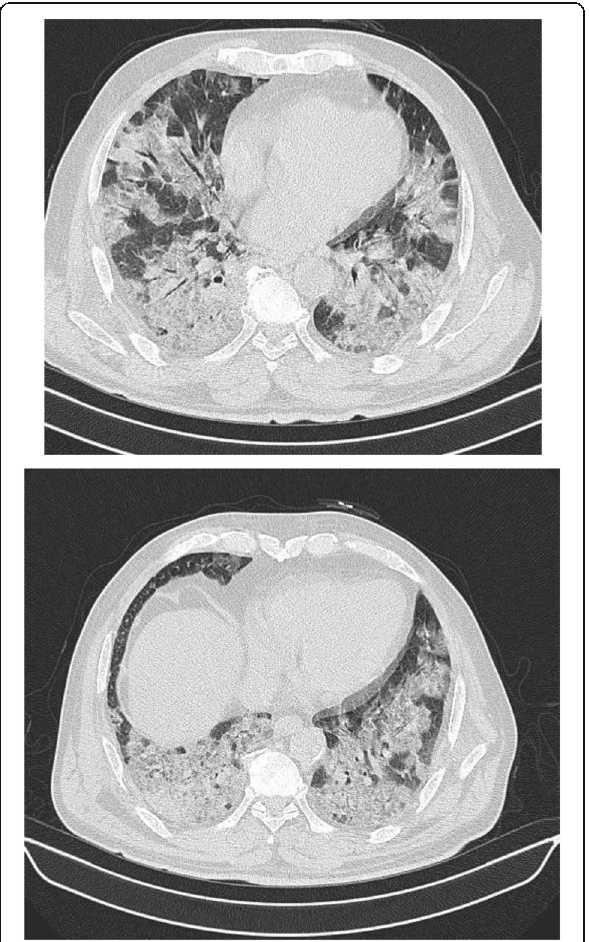
Fig. 4 Patient with COVID-19 pneumonia 10 days after onset of symptoms. Wide areas of ground glass appearance and consolidation with fibrous bands